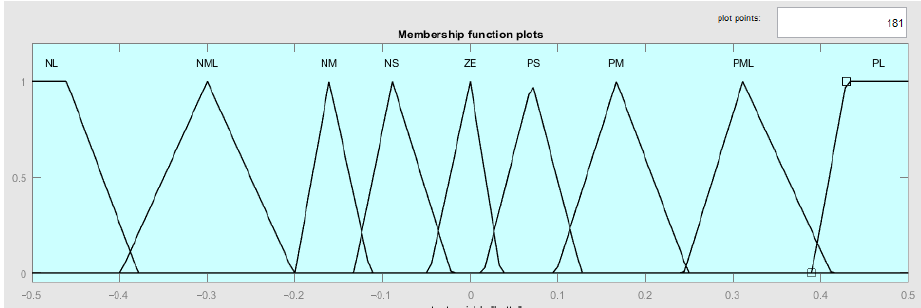
Figure 11. Membership function of the output value “blade pitch angle”.